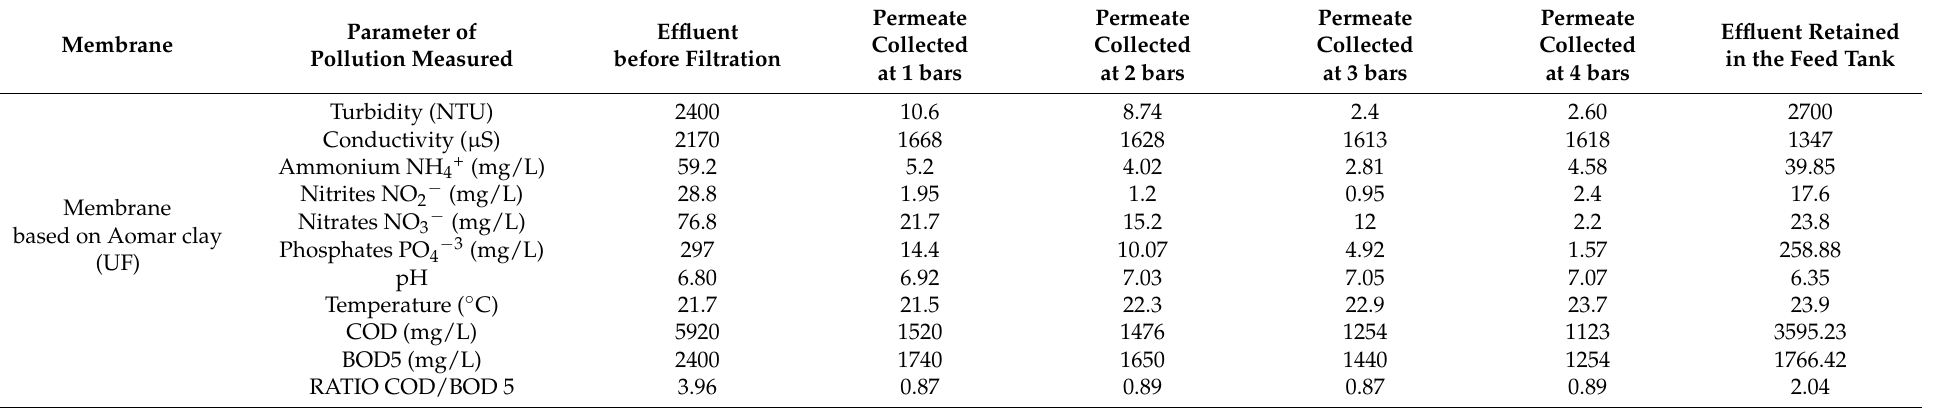
Table 5. Results of the physicochemical-pollution parameters measured on the studied effluent using membrane based on Aomar clay